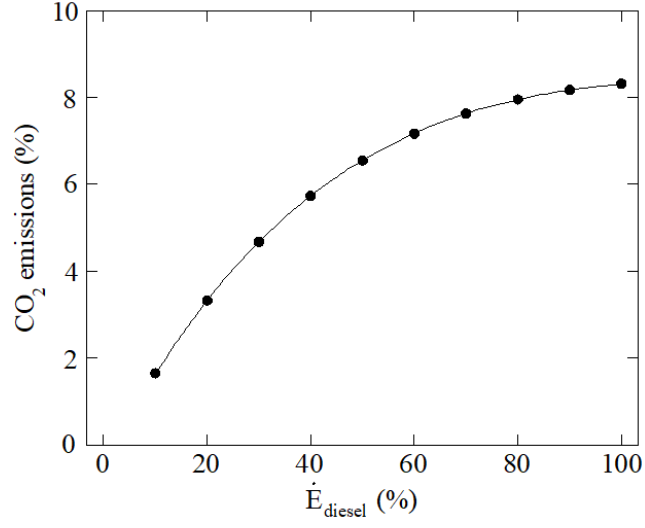
Figure 8. CO 2 emissions against the power contribution from diesel fuel.